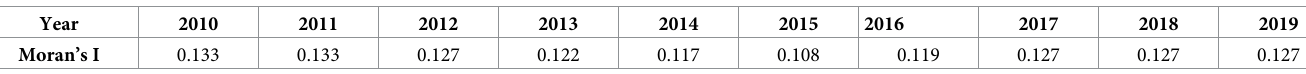
Table 3. Moran’s I of housing prices among large and medium-sized